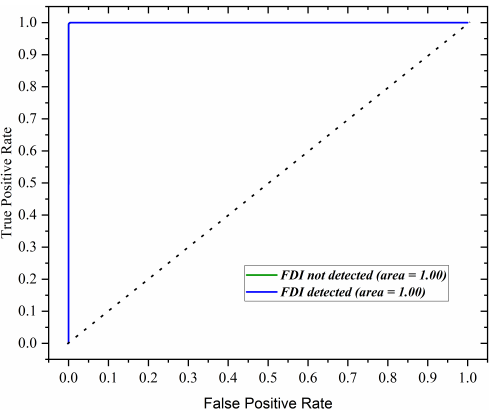
Figure 8. ROC AUC curve of location detection module with XTM.